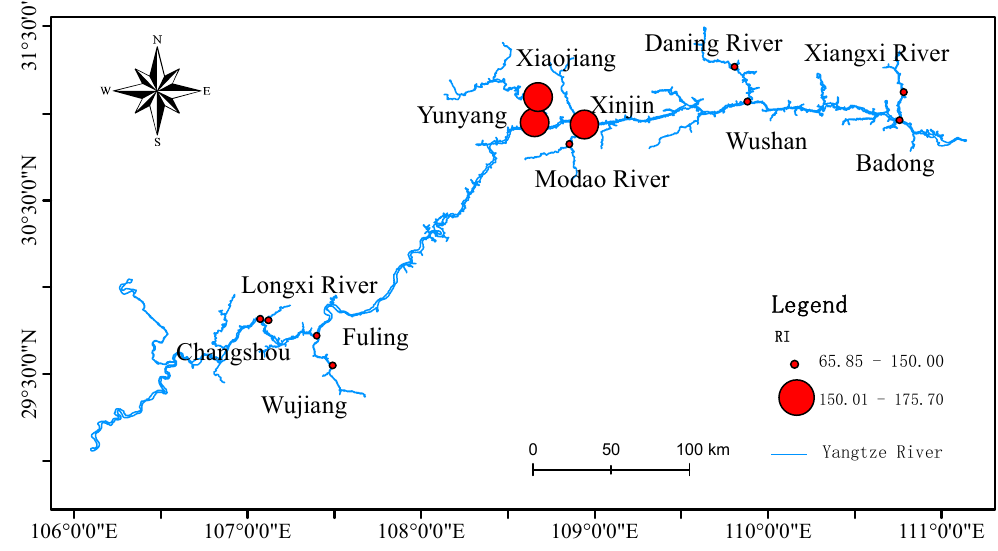
Figure 4. Evaluation results using the comprehensive potential ecological risk index.